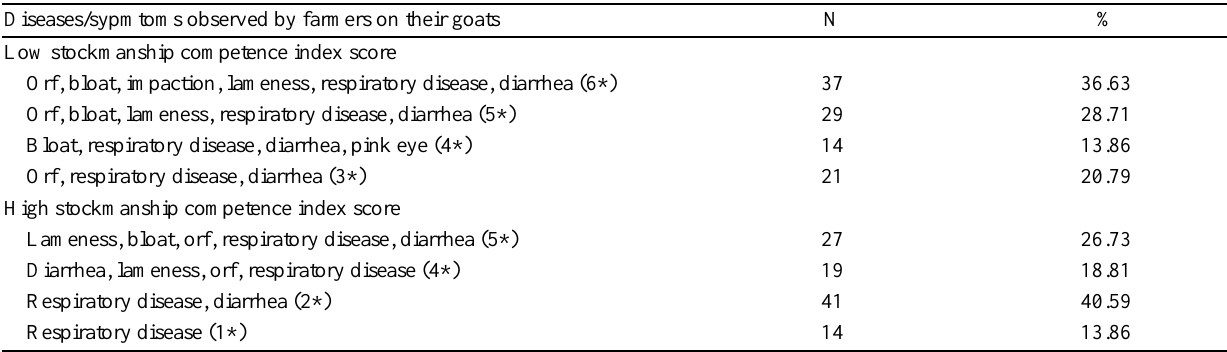
Table 3. Diseases/symptoms observed by farmers on their goats Diseases/sypmtoms observed by farmers on their goats